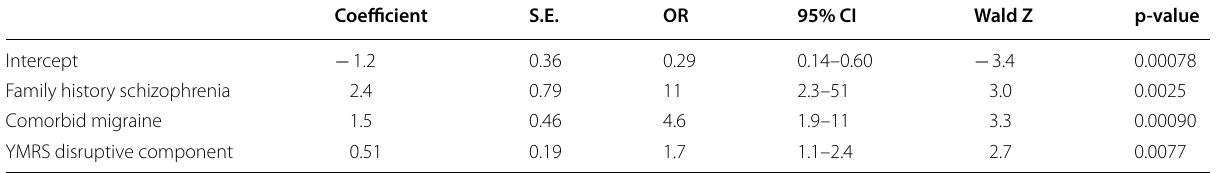
YMRS disruptive S.E. standard error, OR odds ratio, CI confidence interval